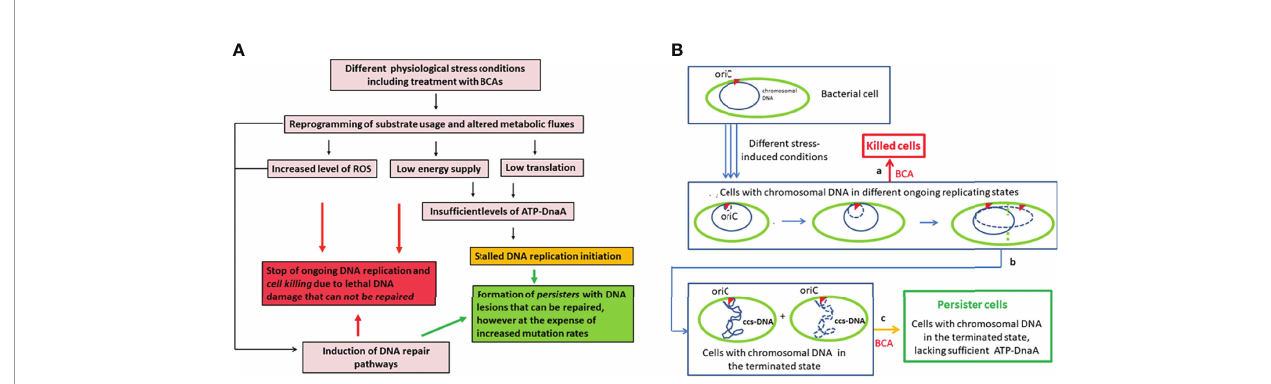
FIGURE 1 | Formation of the antibiotic-tolerant persistence state (according to our hypothesis). (A) Different stress-induced physiological conditions (including treatment with BCAs) lead to increased production of reactive oxygen species (ROS) that damage cell components including DNA, to reduced energy production that inhibits DNA replication and repair, and to reduced metabolic activities. (B) Replicating DNA is particularly sensitive to irreparable damage (especially double strand breaks) which leads to killing of the bacteria (a) . Cells with terminated chromosomal DNA replication but unable to re-initiate replication (due to the lack of suf fi cient ATP-DnaA initiator complex – see text for details) have closed circular supercoiled (ccs) DNA that is rather insensitive to lethal DNA damage (b) . According to our hypothesis, this cellular state arrested in the termination of DNA replication represents the state of persistence (c) . Solid blue circle, parental chromosomal DNA; dashed blue circle, replicating DNA; dashed green vertical line, beginning of cell division; ccs, closed circular supercoiled DNA in the terminated state; oriC, origin of replication marked by the red triangle; BCAs, bactericidal